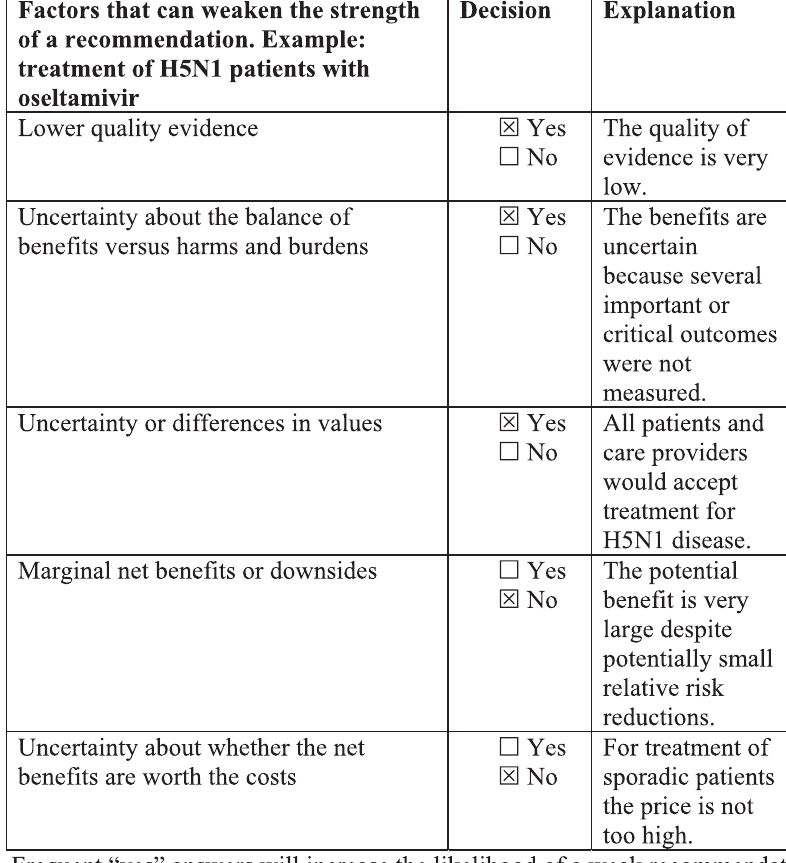
Figure 3. Decisions about the Strength of a